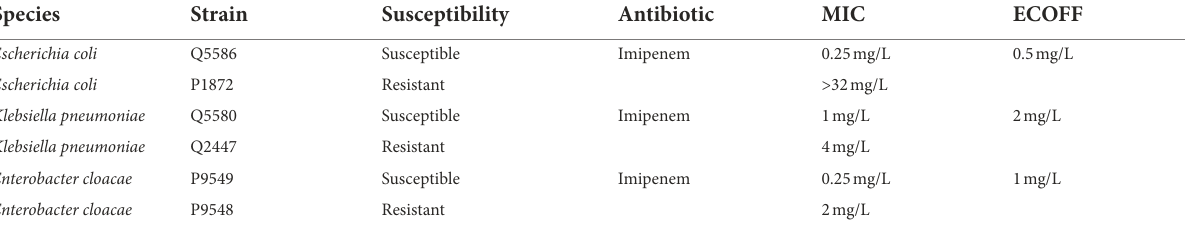
TABLE 1 List of bacteria and antibiotic susceptibility